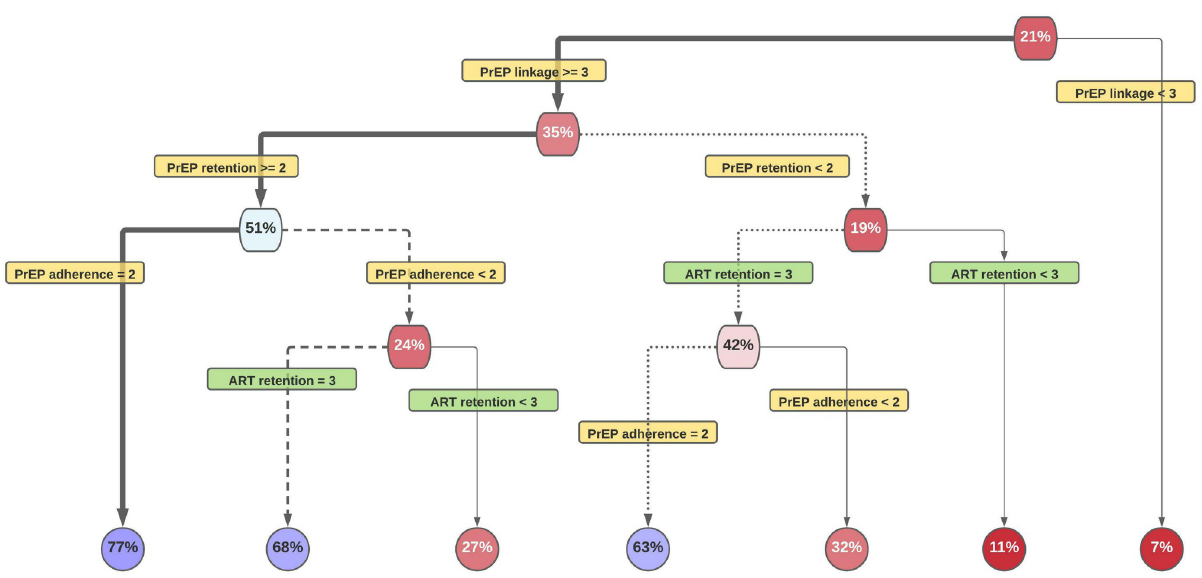
Fig 3. Pathways toward interim EHE goal, 75% reduction of incidence by 2025.